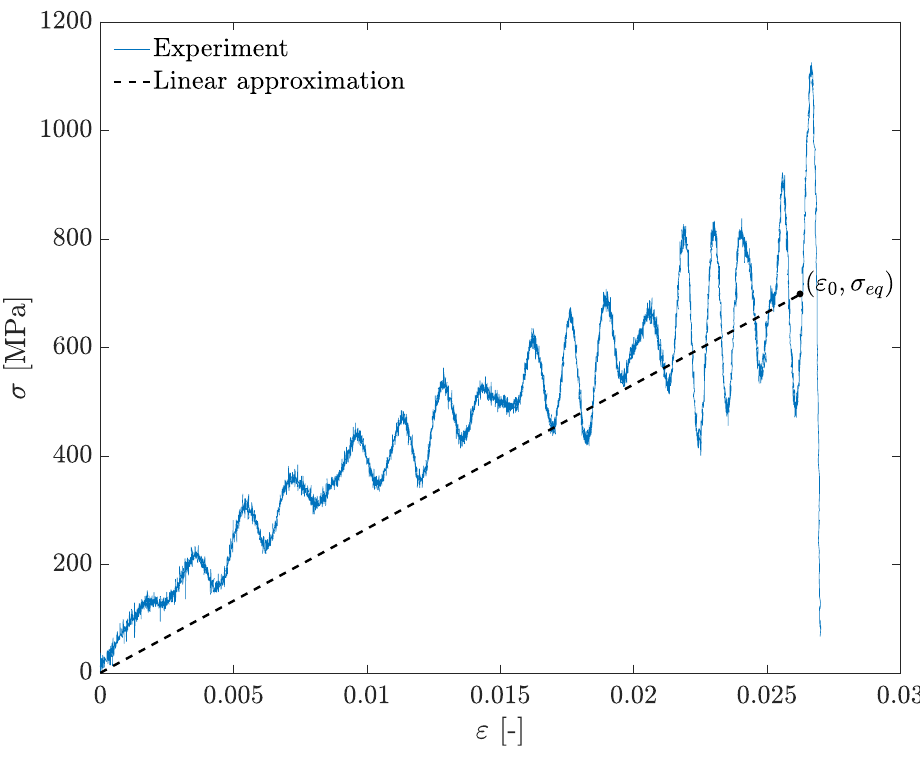
Figure 12. Approximated linear model for the stress-strain profile of the clamp-free experiment presented in Figure 4.